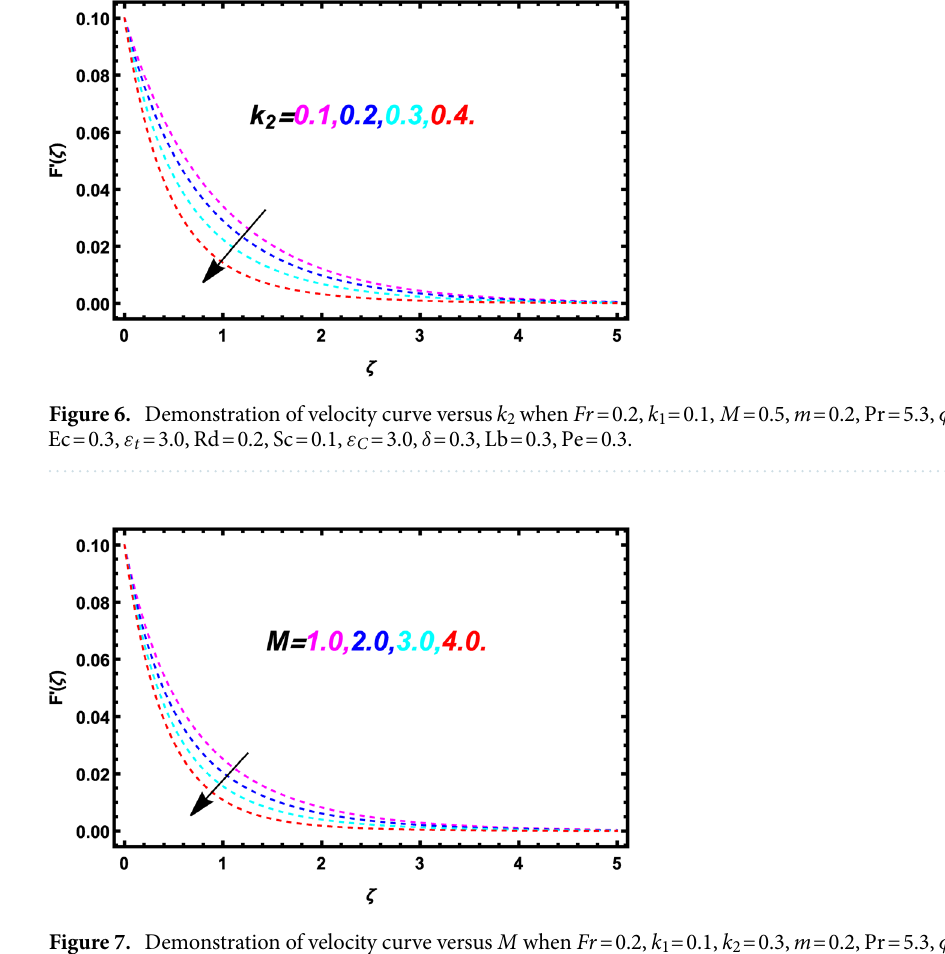
Figure 7. Demonstration of velocity curve versus M when Fr = 0.2, k 1 = 0.1, k 2 = 0.3, m = 0.2, Pr = 5.3, φ = 0.01, Ec = 0.3, ε Rd = 0.2, Sc = 0.1, ε Lb = 0.3, Pe = t = 3.0, C = 3.0, δ = 0.3,